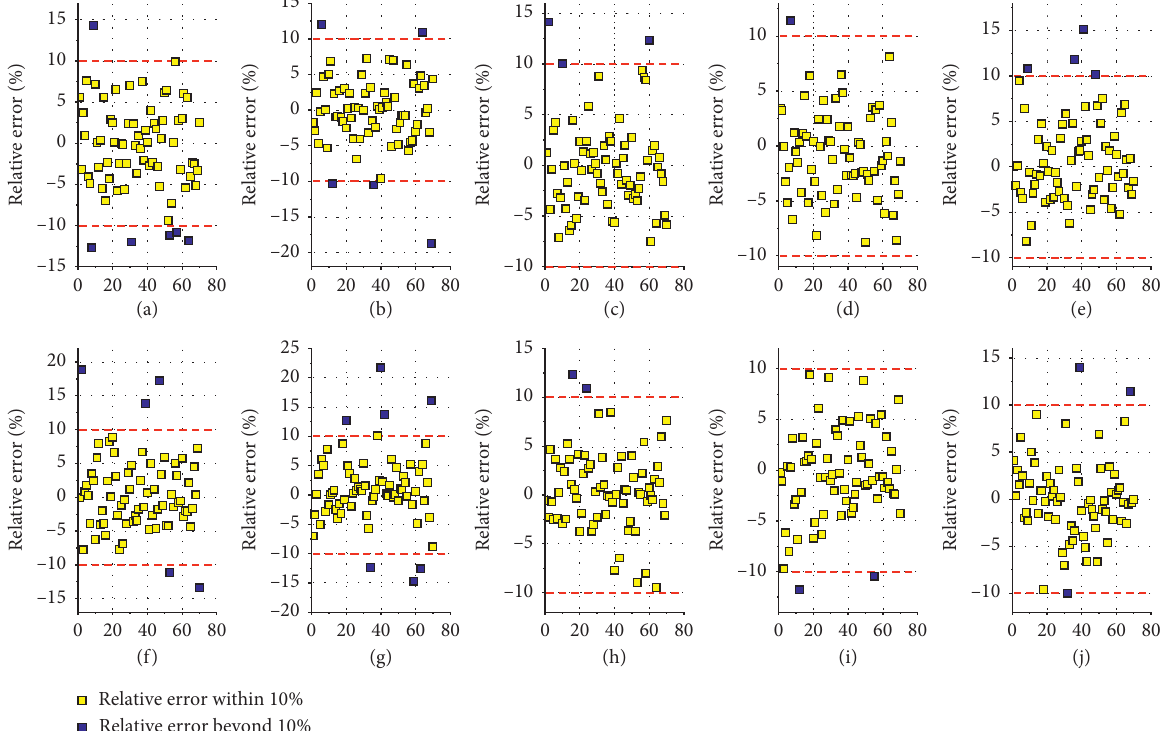
Figure 8: The relative errors between estimated and test CPFR values in ten times tenfold cross-validations. The relative errors within 10% were marked yellow squares while beyond 10% were marked blue squares. (a) Test (1). (b) Test (2). (c) Test (3). (d) Test (4). (e) Test (5).